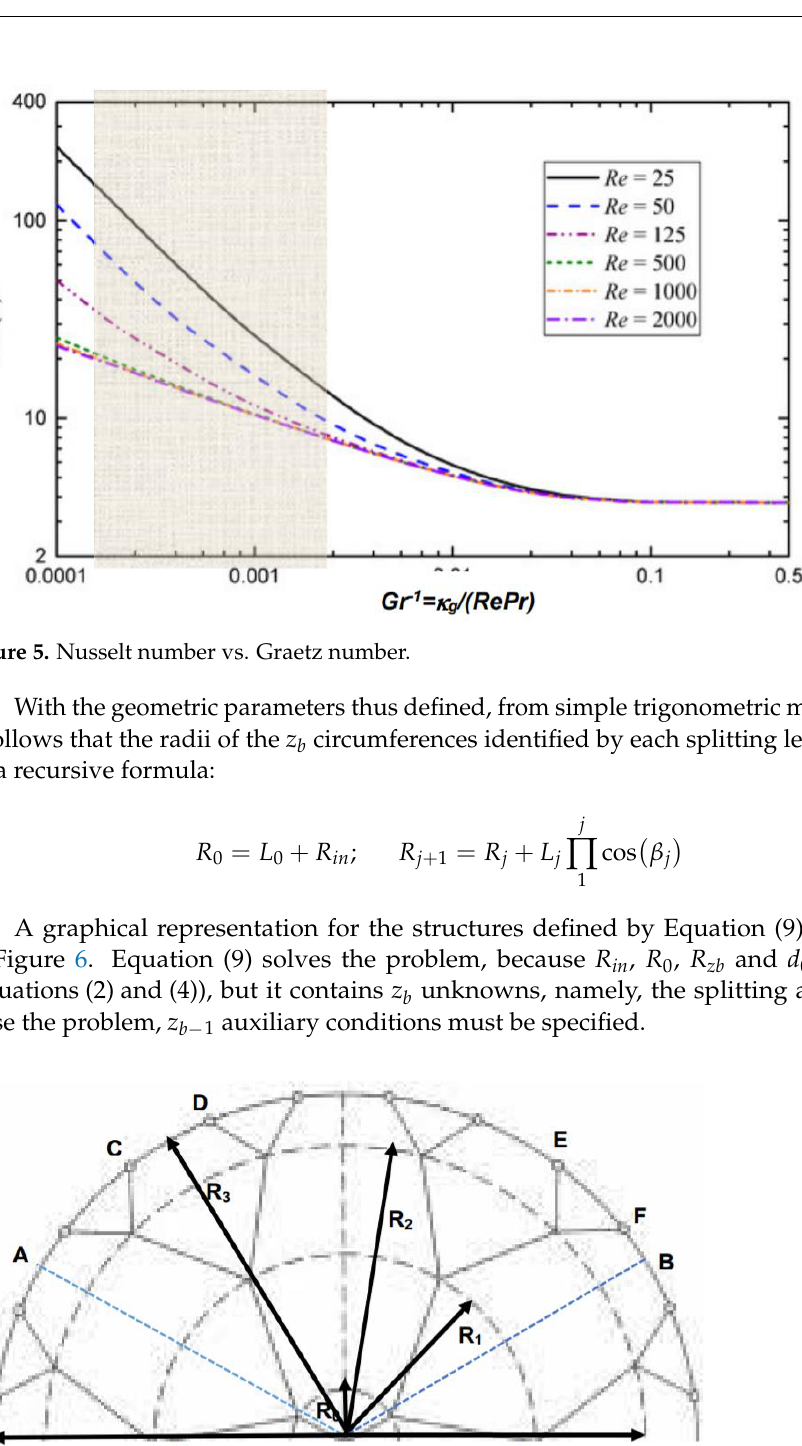
Figure 6. Identification of the radii of successive branchings (here, z 0 = 3, z b = 3).